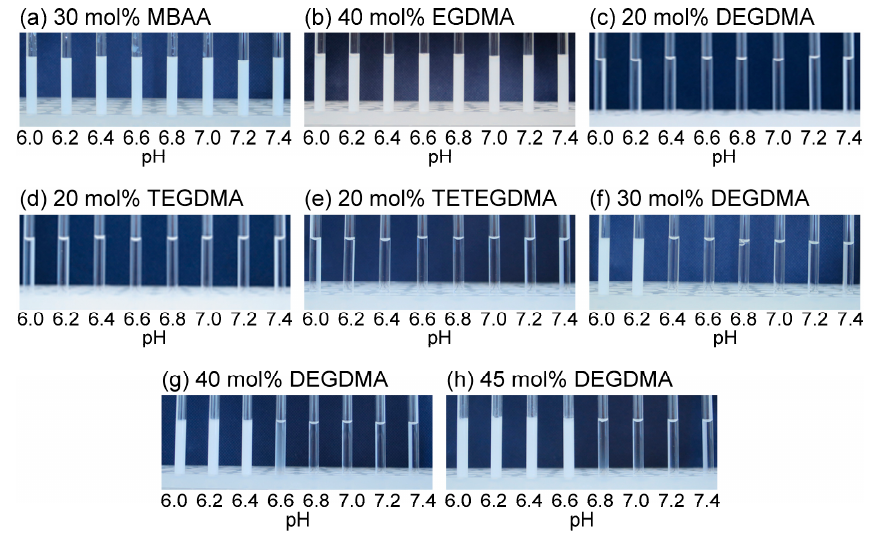
Figure 2. The phase transition behaviors of the poly(methacrylic acid) cross-linked with ( a ) 30 mol% MBAA, ( b ) 40 mol% EGDMA, ( c ) 20 mol% DEGDMA, ( d ) 20 mol% TEGDMA, ( e ) 20 mol% TETEGDMA, ( f ) 30 mol% DEGDMA, ( g ) 40 mol% DEGDMA, and ( h ) 45 mol% DEGDMA in 100 mM phosphate buffer, pH 6.0 to 7.4 with 0.2 increments at room temperature. [microgel] = 0.50 wt%.